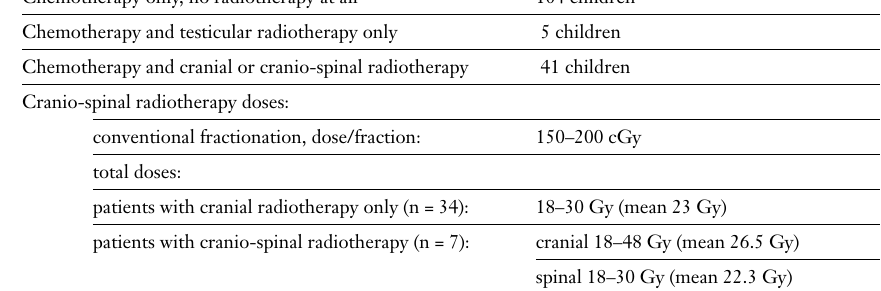
Treatment details (n = 150